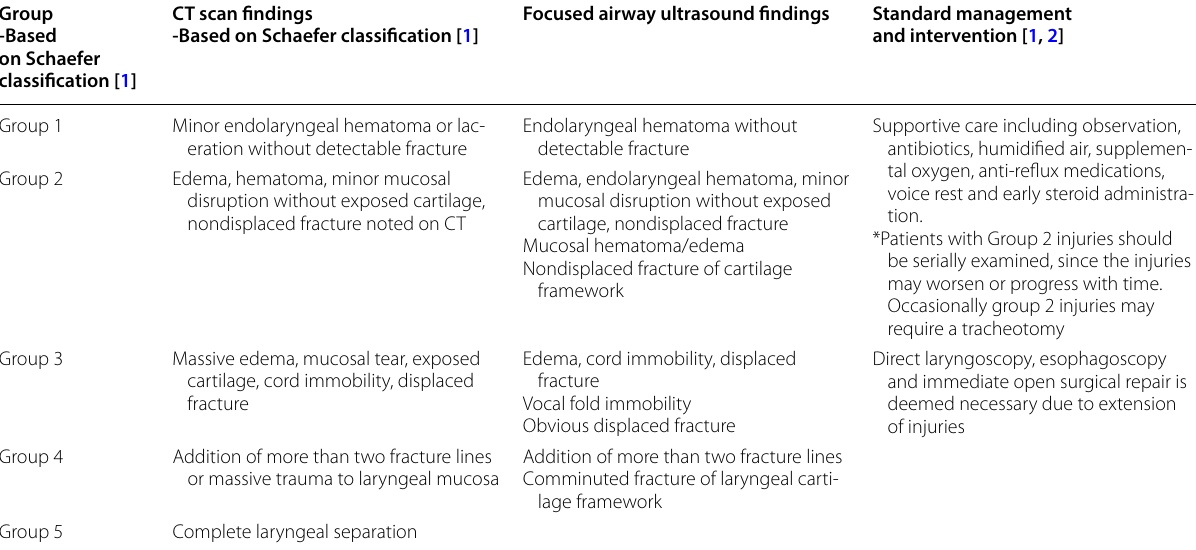
Table 1 Proposed focused airway ultrasound findings in correlation to the Schaefer Classification System and